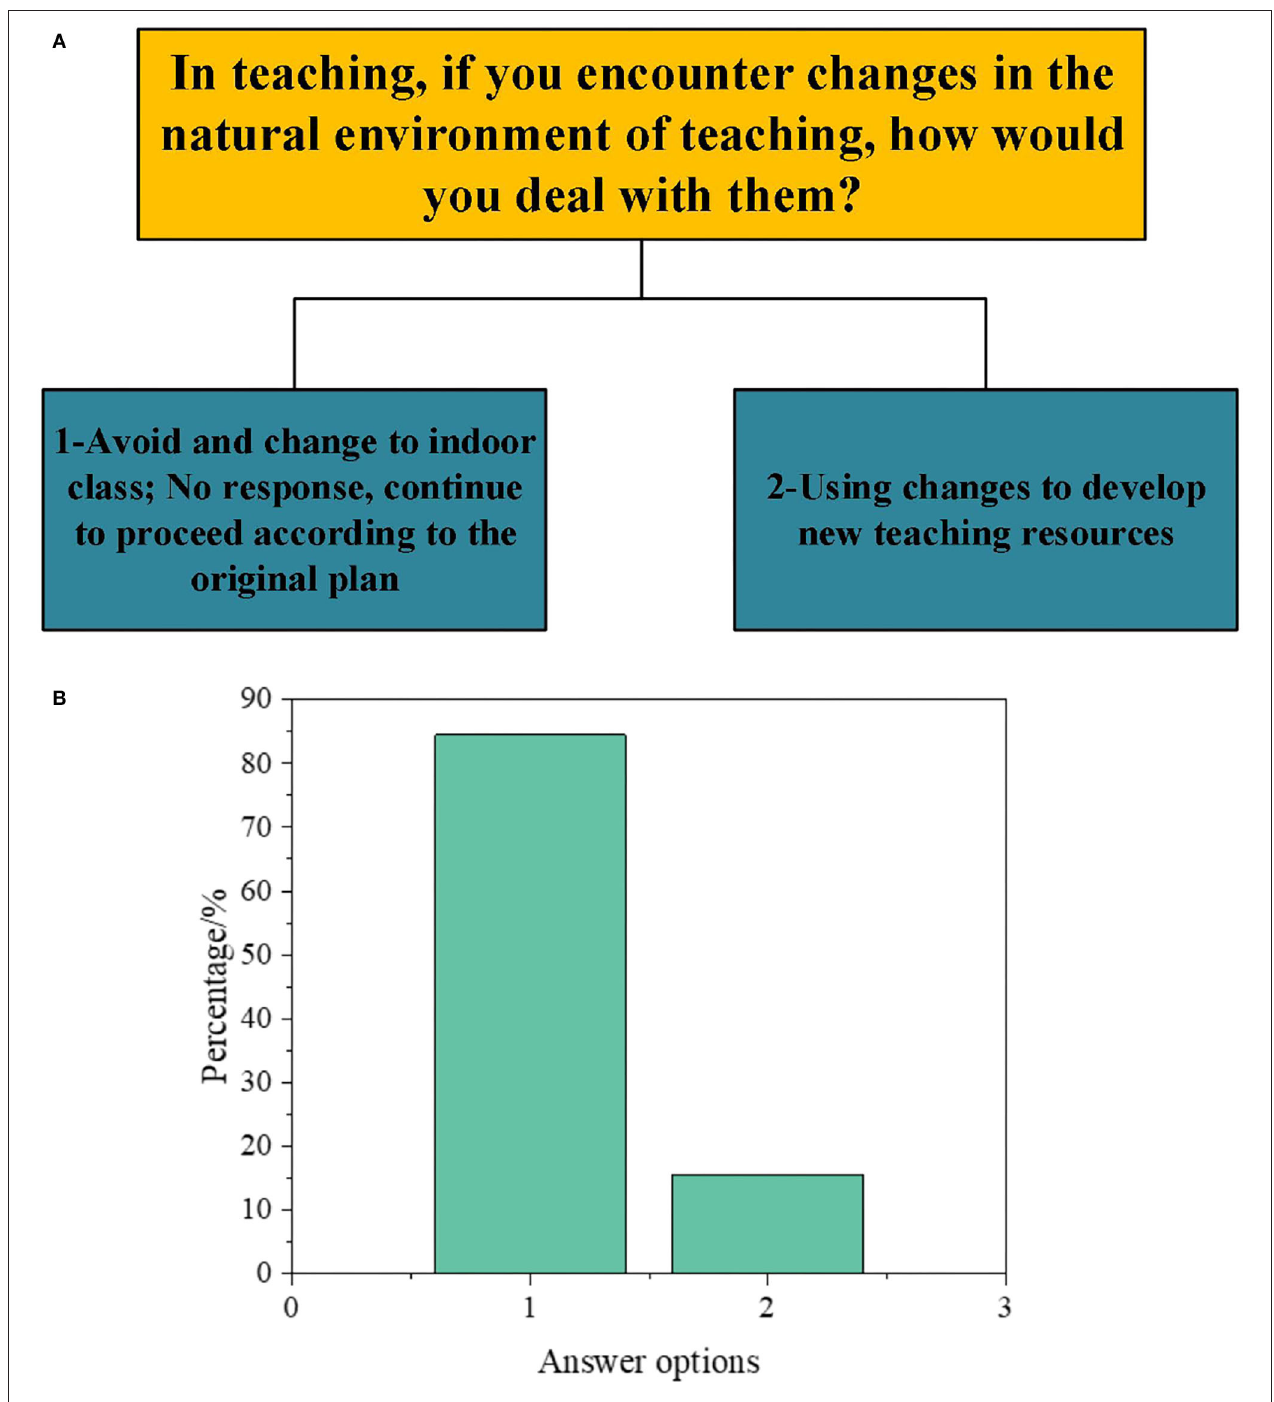
FIGURE 5 | Interview data on the DAU of natural environment-oriented GCR [ (A) : questions and options; (B) : proportion of